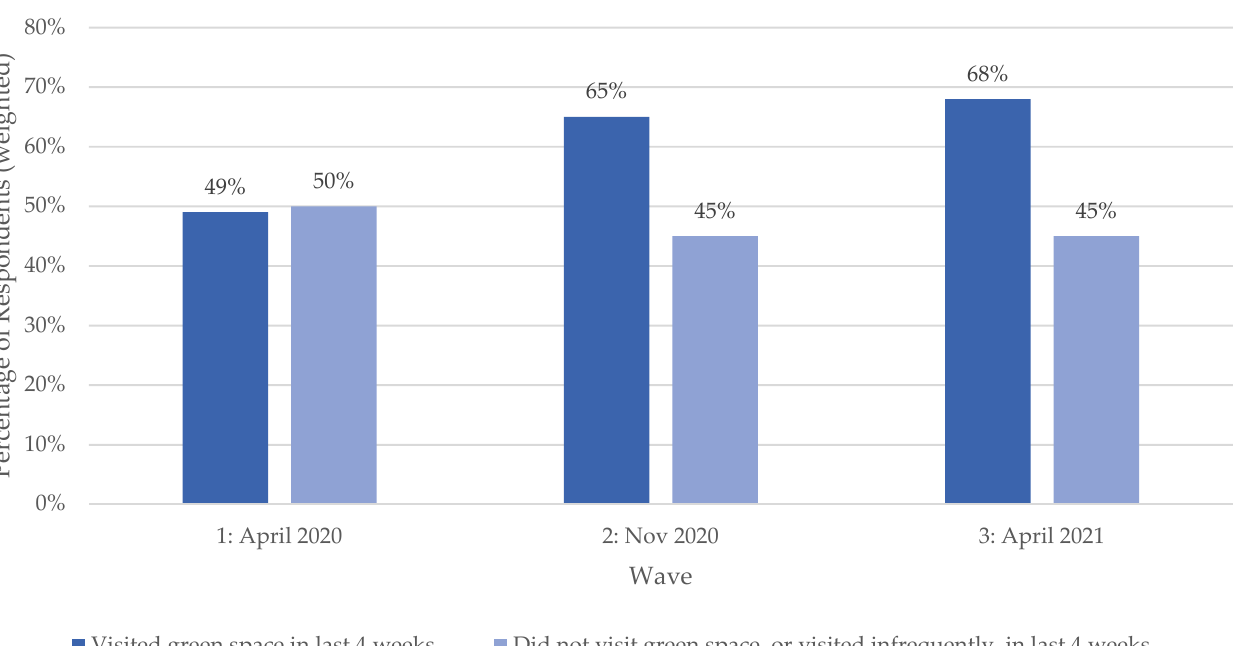
Figure 1. Change in the percentage of respondents stating visits to green space over the three survey waves (all significant Chi 2 , p -values < 0.05).